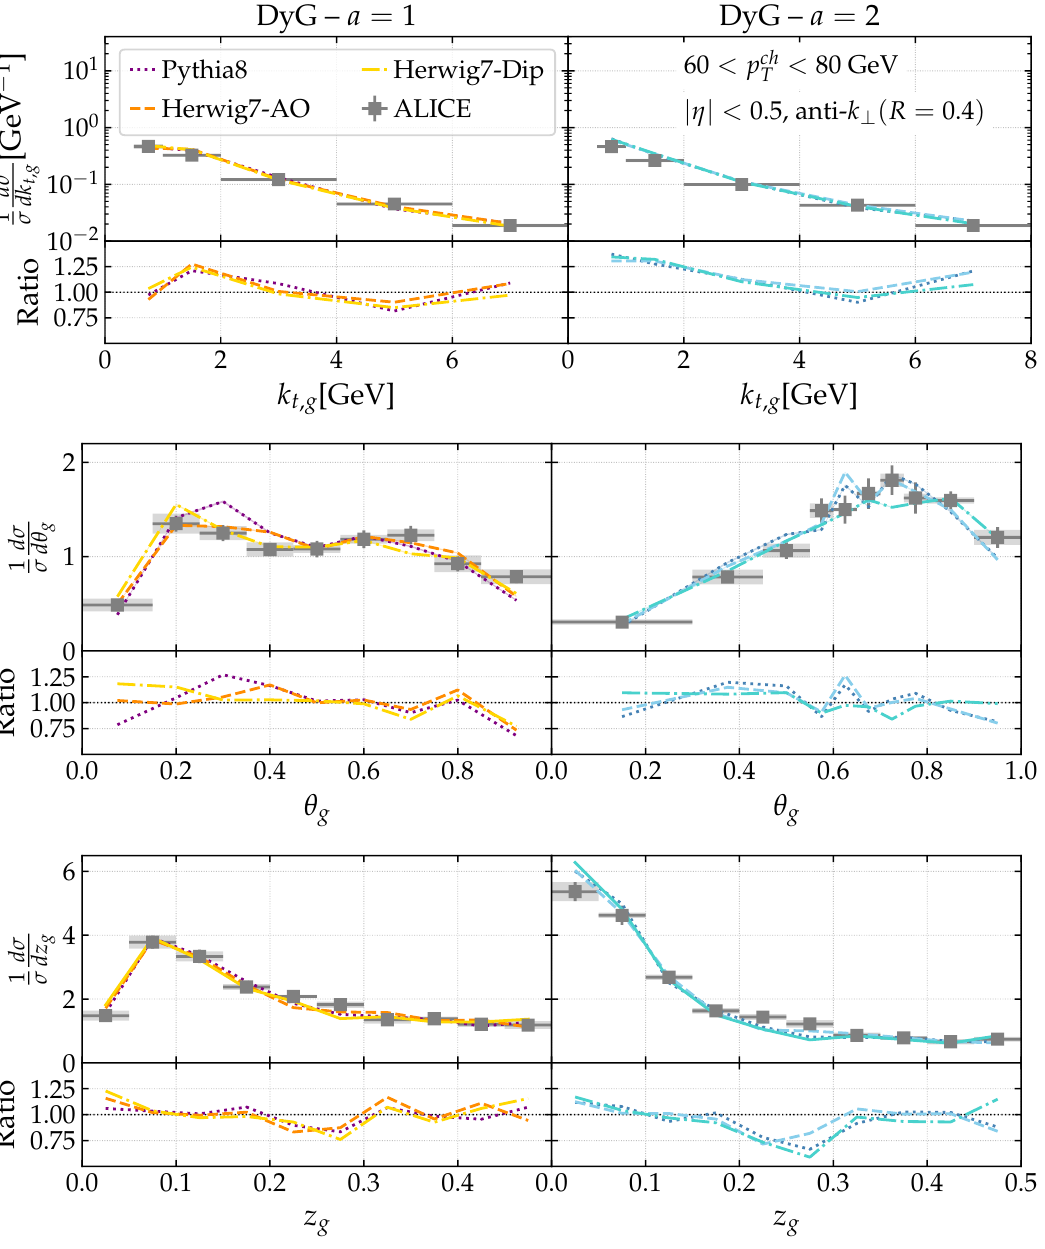
Figure 15 . Monte-Carlo to data comparison of k t,g (top), θ g (middle) and z g (bottom) for a = 1 (left) and a =2 (right) in the Dynamical Grooming condition, see eq. (1.1). In the bottom panels, the theory-to-data ratios, computed using the same binning as the data, are